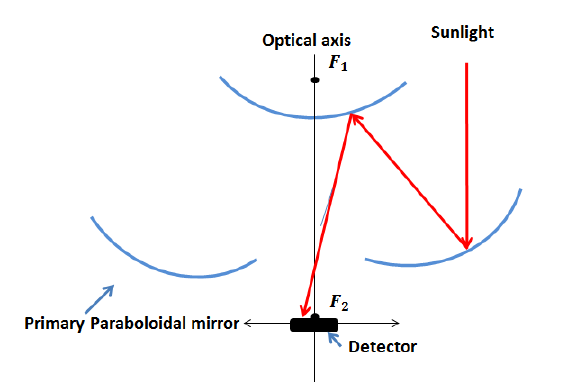
Figure 37. Solar concentrator with two stages based on two mirrors [68]. Reprinted from C. Chen et al., Design of a solar concentrator combining paraboloidal and hyperbolic mirrors using ray tracing method, Optics Communications 2009, 360–366, with permission from Elsevier.